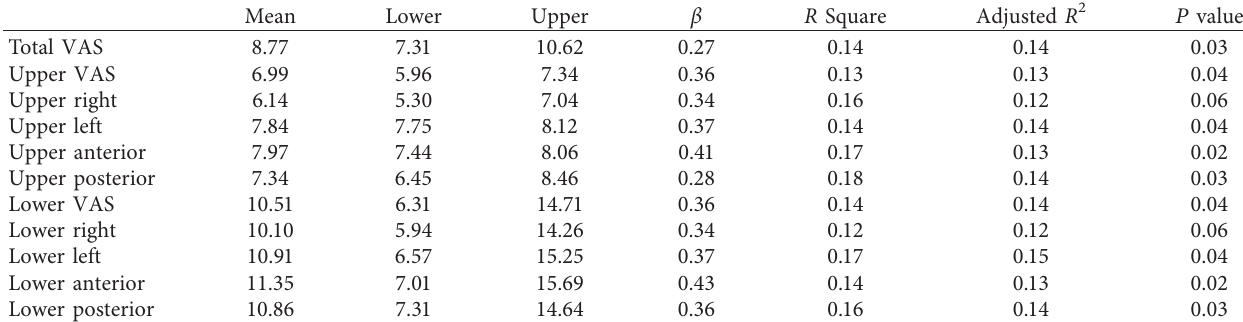
Table 4: Regression analysis for VAS with treatment